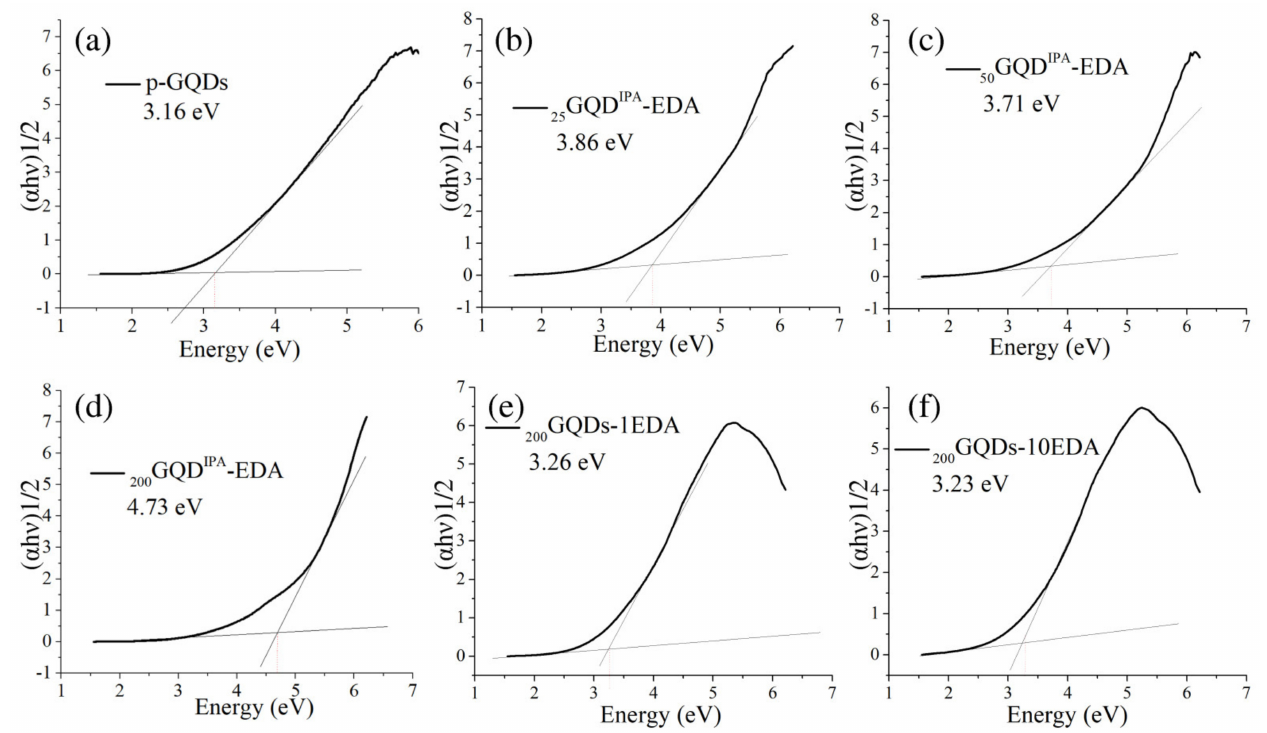
Figure 2. Tauc plots graphs for p-GQDs ( a ), 25 GQD IPA -EDA ( b ), 50 GQD IPA -EDA ( c ), 200 GQD IPA -EDA ( d ),